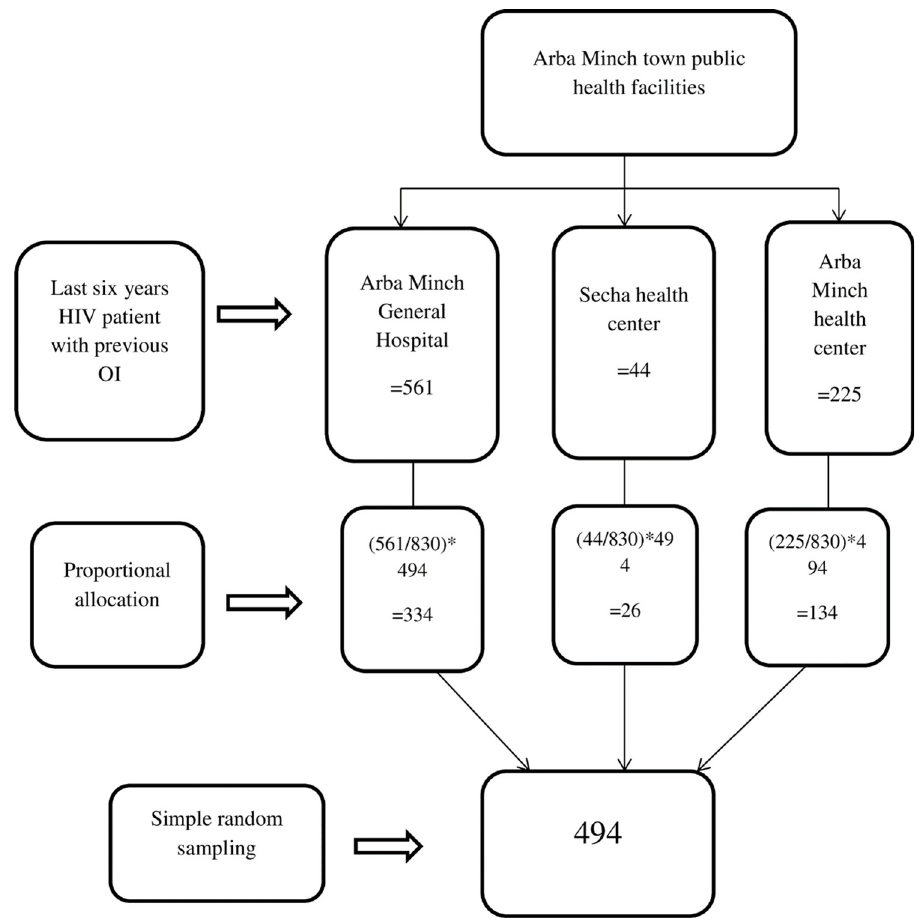
Fig 1. Sampling procedure for current